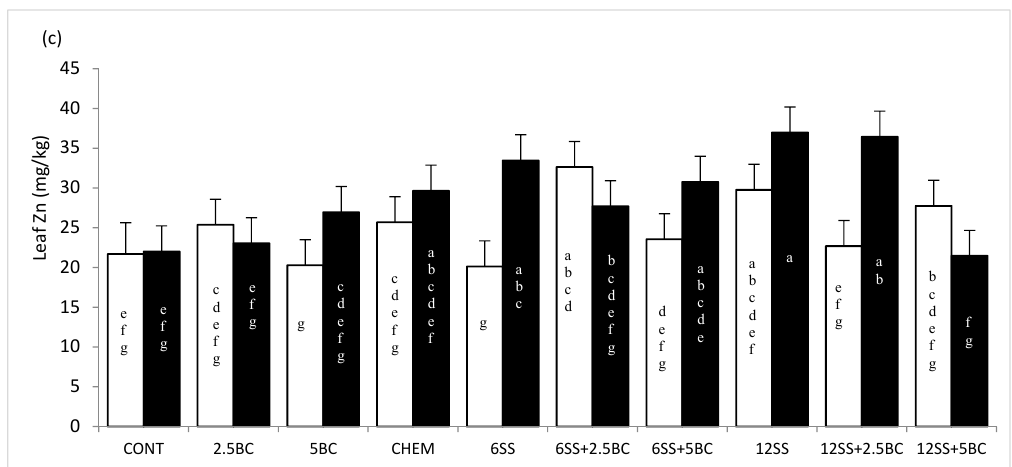
Figure 2. Leaf contents of ( a ) Mehlich Cu, ( b ) Mehlich Fe, ( c ) Mehlich Zn at the end of the season. For each variable, columns for both soil types with different letters are significantly different ( p < 0.05) according to Duncan’s multiple range test. Comparison of treatment means for both soil types indicate the statistics were done simultaneously. Error bars denote standard error of the mean (SEM) ( n = 3).